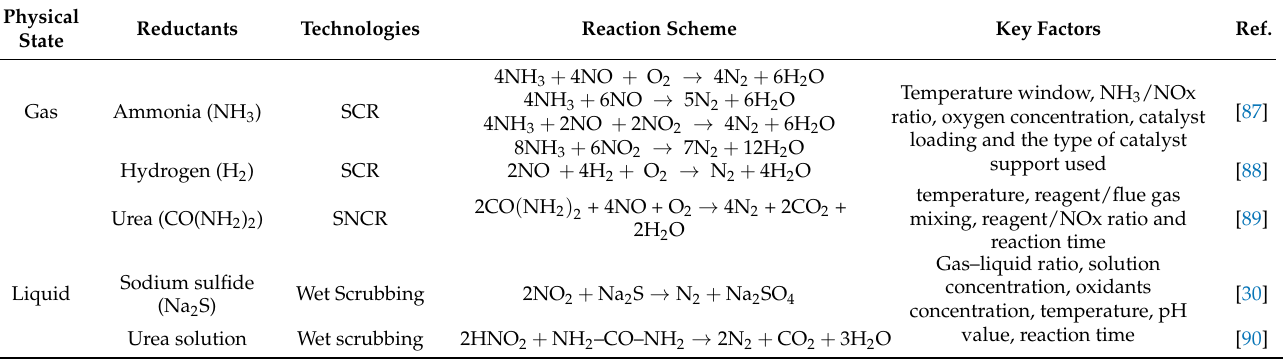
Table 4. Typical reductants used for technologies of NOx